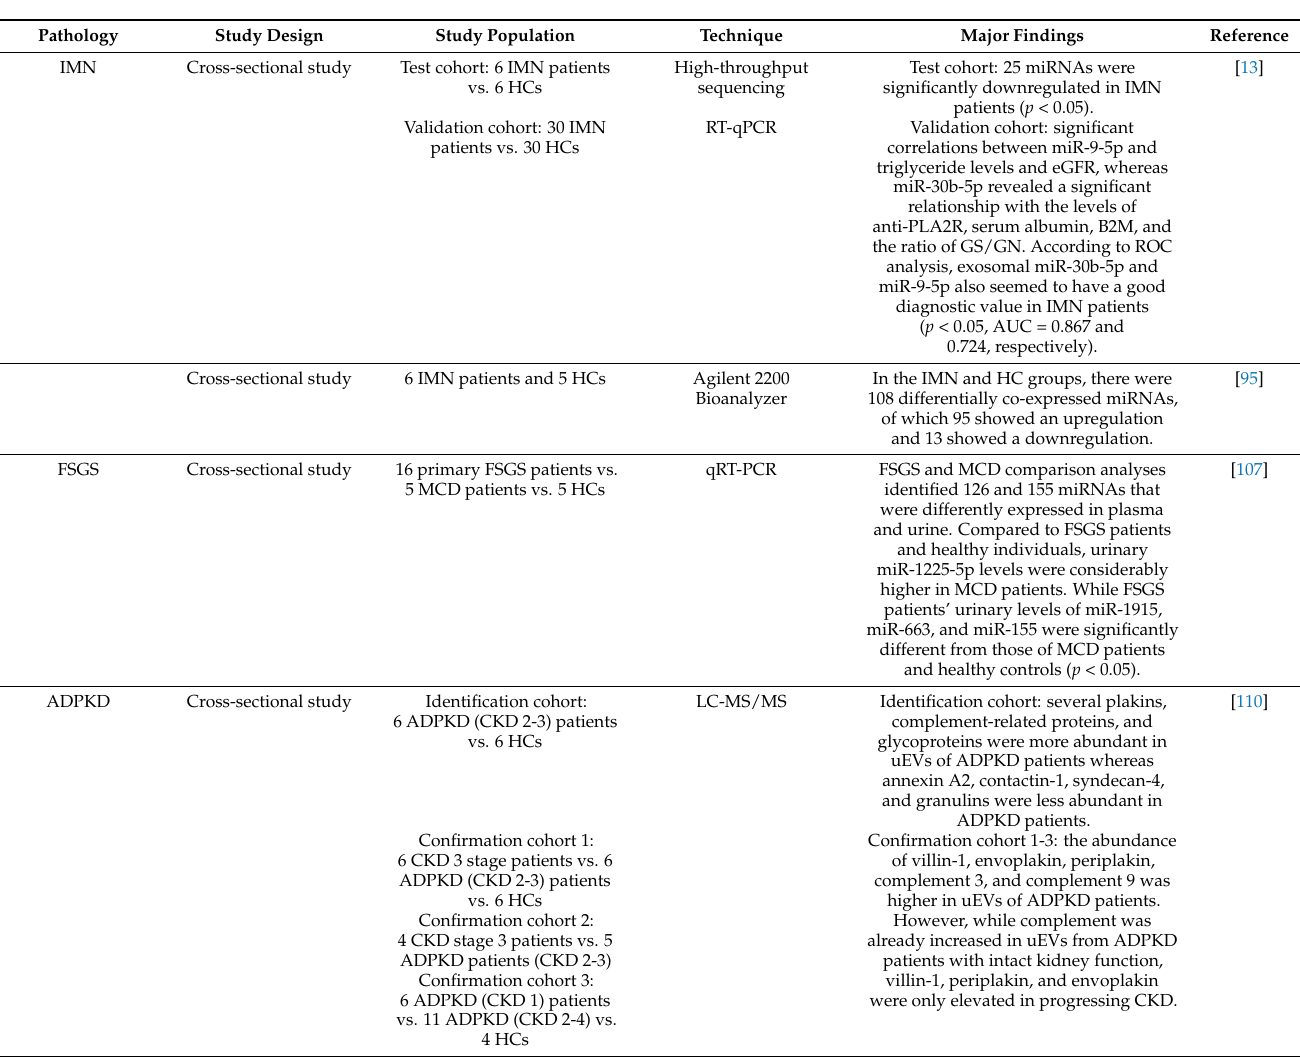
Table 4. Overview of studies of urinary vesicles in idiopathic membranous nephropathy, focal segmental glomerulosclerosis, ADPKD, and medullary sponge kidney disease. IMN: idiopathic membranous nephropathy; HCs: healthy controls; RT-qPCR: real-time quantitative polymerase chain reaction; eGFR: estimated glomerular filtration rate; Anti-PLA2R: anti-phospholipase A2 recep- tor antibody; B2M: β 2-microglobulin; GS/GN: global sclerosis/observed glomeruli number; ROC: receiver operating characteristics curve; AUC: area under the curve; FSGS: focal segmental glomeru- losclerosis; MCD: minimal change disease; ADPKD: autosomal dominant polycystic kidney disease; CKD: chronic kidney disease; LC–MS/MS: liquid chromatography–tandem mass spectrometry; uEV: urinary extracellular vesicles; MSKD: medullary sponge kidney disease; MS: mass